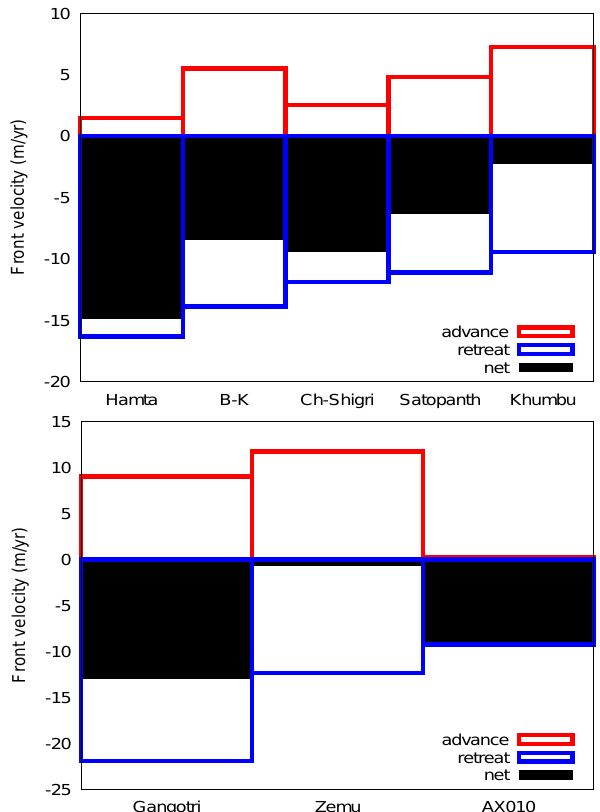
Fig. 11. Bar chart showing the balance of the opposing tenden- cies of advance due to dynamics (red boxes), retreat due to ther- modynamics (blue boxes) and the net movement (black bars). The glaciers are arranged in increasing order of slope. Figures on the top are for the fitted set and those on the bottom are for the predicted